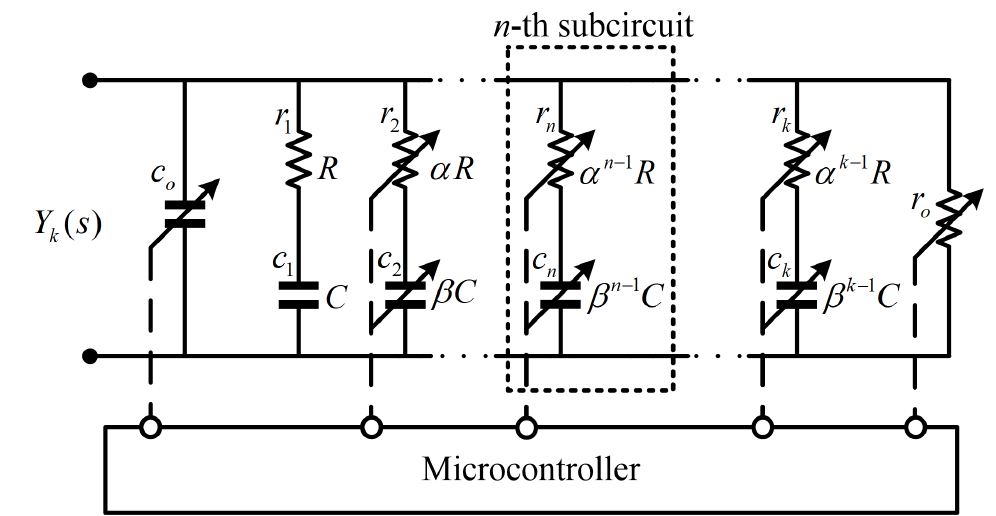
Figure 1. Circuit configuration of